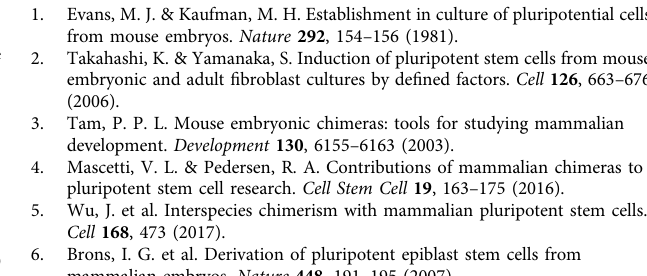
Table 1. Immuno fl uorescence . The injected blastocyst embryos and frozen sections of E10.5 mouse chimeric embryos and placenta were incubated with antibodies (Stem121, Calponin, PAX6, OCT4, CK7, CDX2, and TPBPA) overnight at 4°C, washed with PBS and incubated with speci fi c secondary antibody. Nuclei were stained with DAPI. Stained embryos and sections were observed using a LSM800 confocal microscope (Carl Zeiss). Antibodies were listed in Supplementary Table 2.